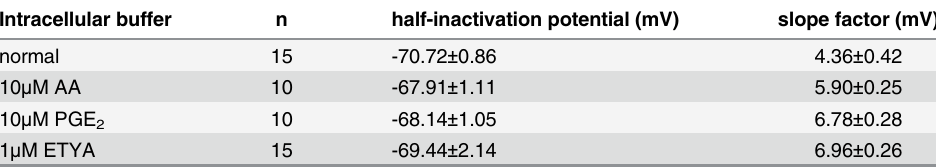
Table 2. The half-inactivation potential and slope factor of inactivation curve of rNaV1.4. Intracellular